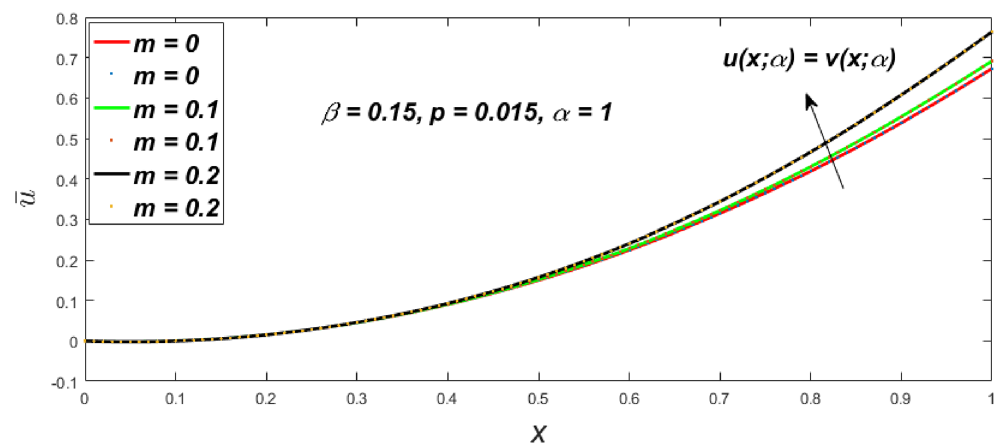
Figure 35. Fuzzyvelocity for the impact of m.